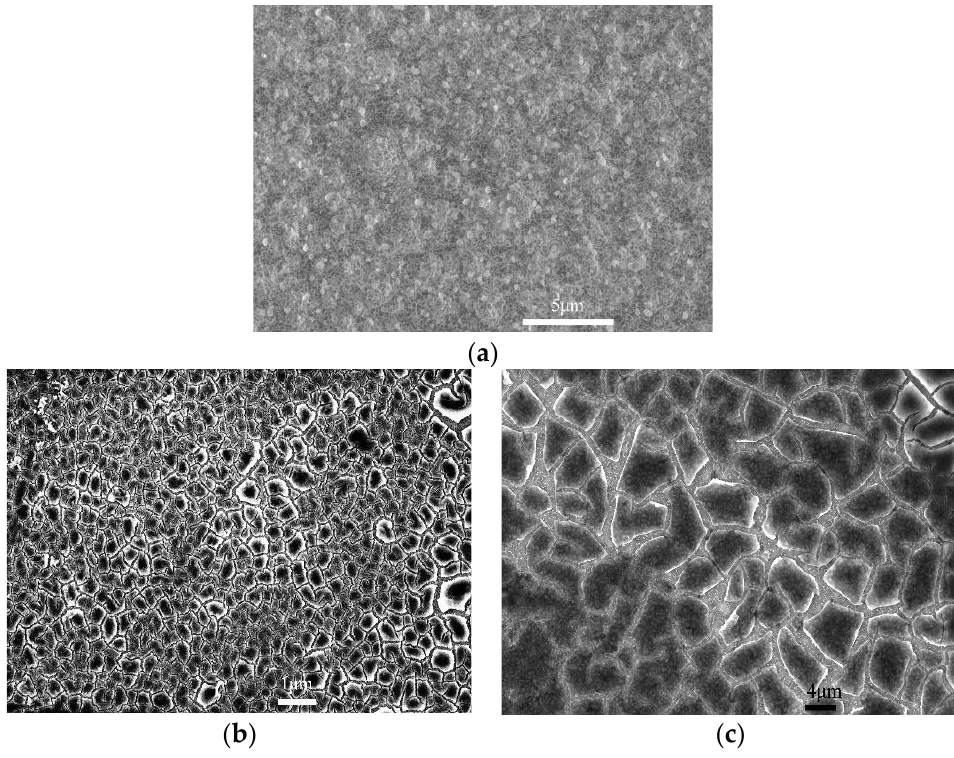
Figure 4. The FESEM images of Mg 2 Si/Si and MLG/Mg 2 Si/Si heterojunctions. ( a ) the FESEM images of Mg 2 Si/Si; ( b ) the FESEM images of MLG/Mg 2 Si/Si at a magnification of 1000 times; ( c ) the FESEM images of MLG/Mg 2 Si/Si at a magnification of 2000 times.